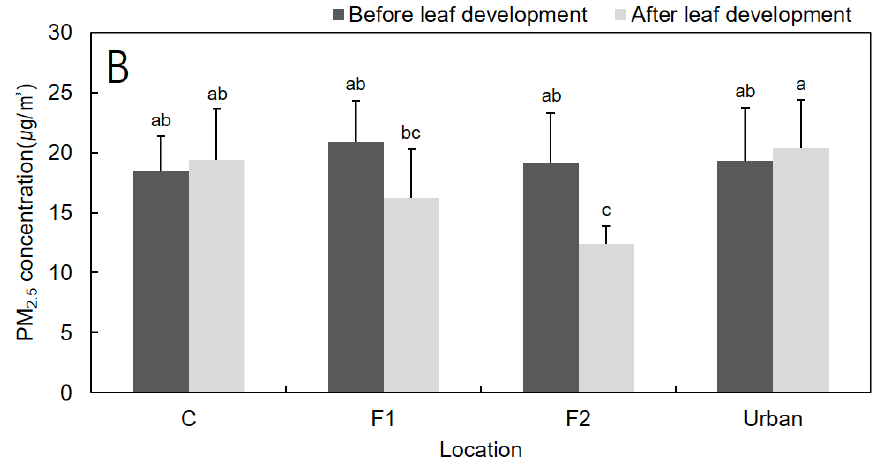
Figure 3. Seasonal changes in PM concentration ( µ g/m 3 ) in Yeouido Saetgang Ecological Park. ( A ) PM 10 concentration before and after leaf development at the measuring points. ( B ) PM 2.5 concentration before and after leaf development at the measuring points. The same letter indicates no significant difference between measurements ( p < 0.05, one-way ANOVA and then Tukey’s test for multiple comparisons). Values are shown as means ± standard deviation. C; control, F1 and F2; urban forest site 1 and 2, respectively, Urban; Urban area. Table 2. Meteorological conditions at two willow forests in Yeouido Saetgang Ecological Park during the study period. Region